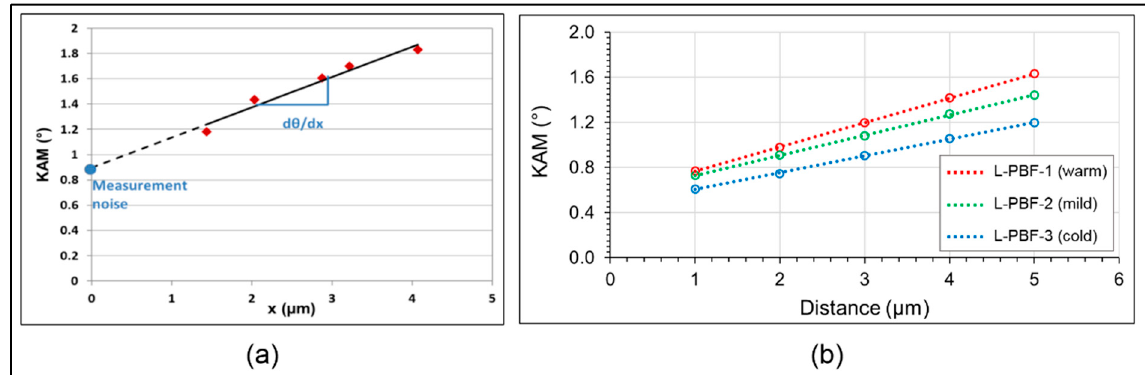
Figure 9. The orientation gradient d/dx , which allows estimation of the density of the geometrically necessary dislocations ( GND ), is measured by considering the linear increase of the kernel average misorientation (KAM) as a function of the distance between EBSD pixels, as reprinted from [33] ( a ). In the vast majority of our data, a very clear linear tendency was found, indicating a well-adapted procedure to our specimens ( b ).